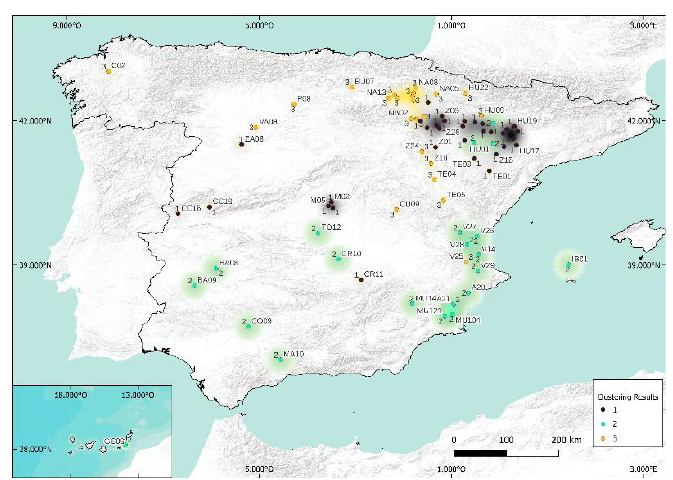
Figure 18. Using spectral for 3 clusters.